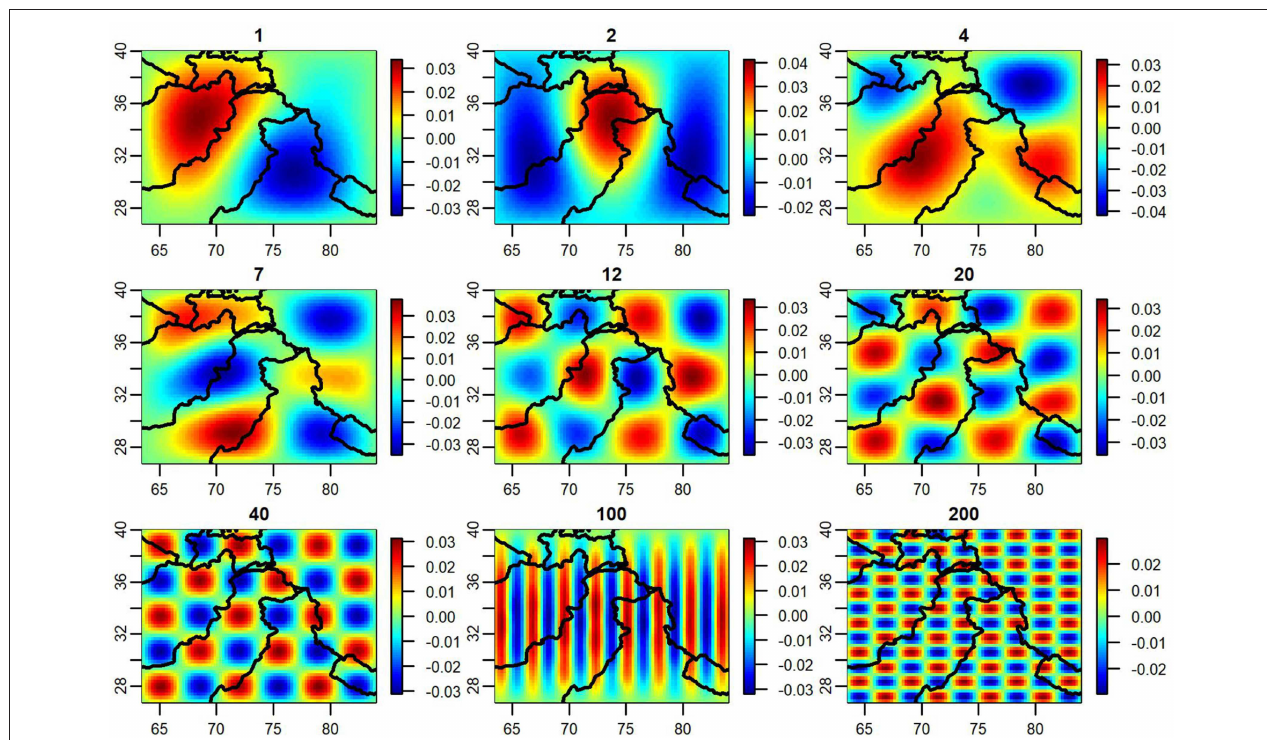
FIGURE 2 | Spatial eigenvectors from decomposed Moran